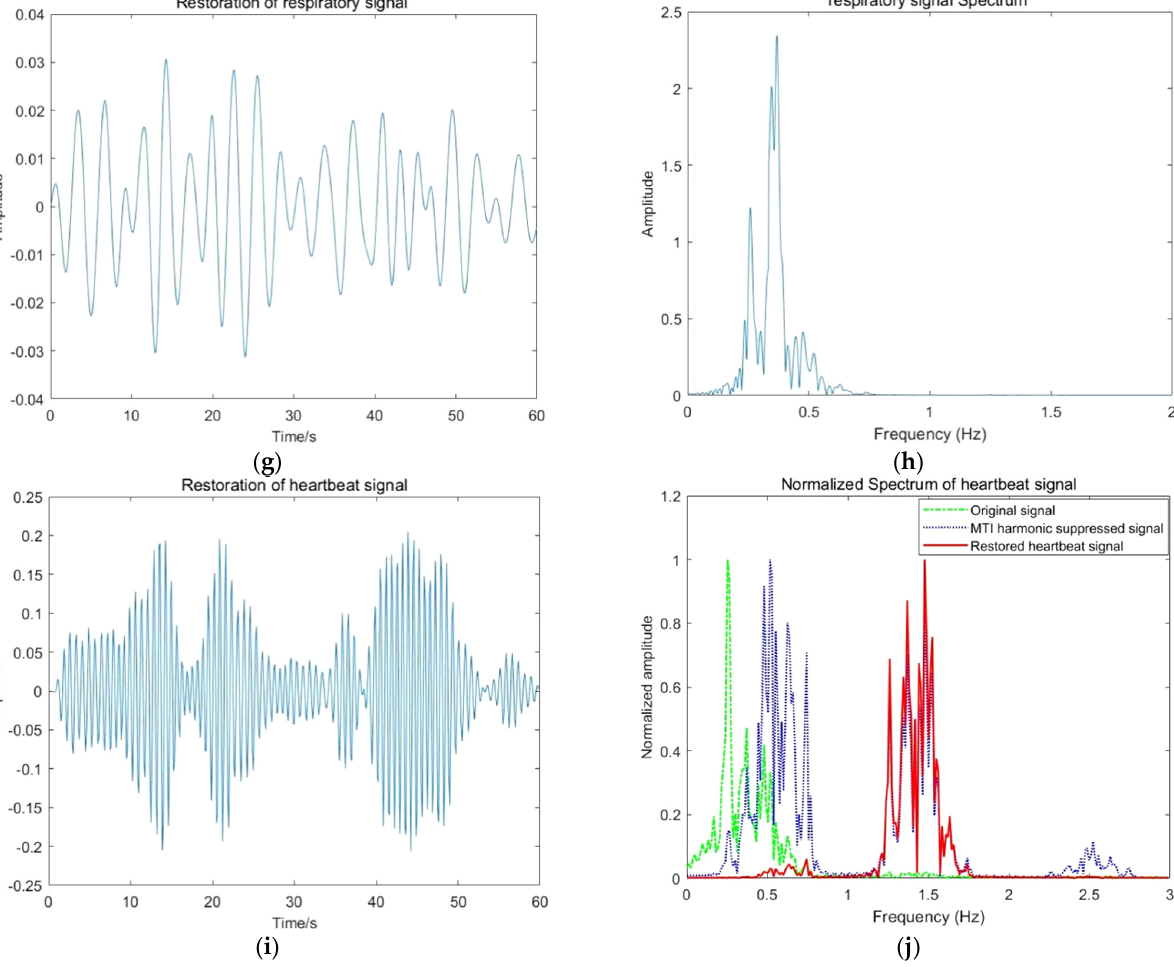
Figure 27. Results of essential steps for experiment group 4: ( a ) Radar raw data; ( b ) Radar data after preprocessing; ( c ) The relative principal component; ( d ) Spatial eigenvector; ( e ) Temporal eigenvector; ( f ) Energy entropy; ( g ) Restoration of respiratory signal; ( h ) Respiratory signal spectrum; ( i ) Restoration of heartbeat signal; ( j ) Heartbeat signal spectrum.